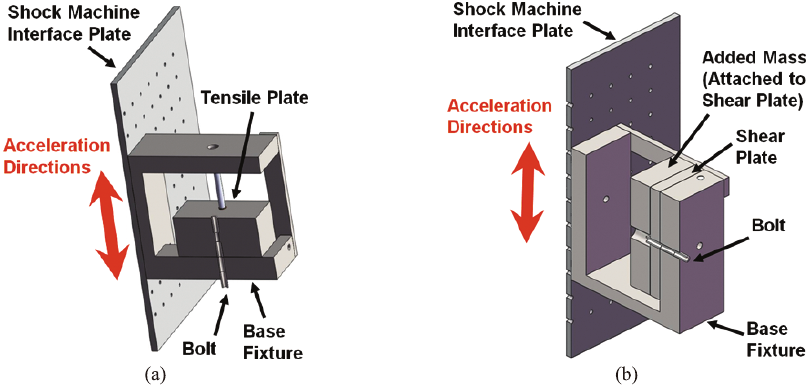
Fig. 3. Section view of (a) dynamic tension test; (b) dynamic shear